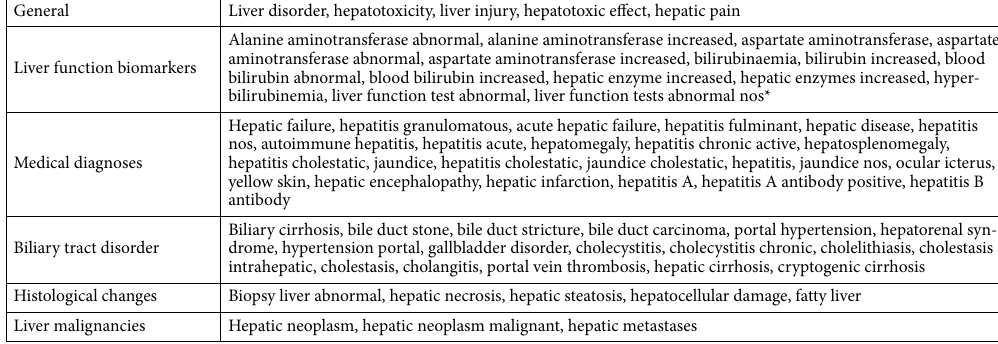
Table 4. Liver-related adverse events coded as MedDRA terms in Vigibase were classified into 6 prime categories of important liver endpoints. *nos not otherwise specified.